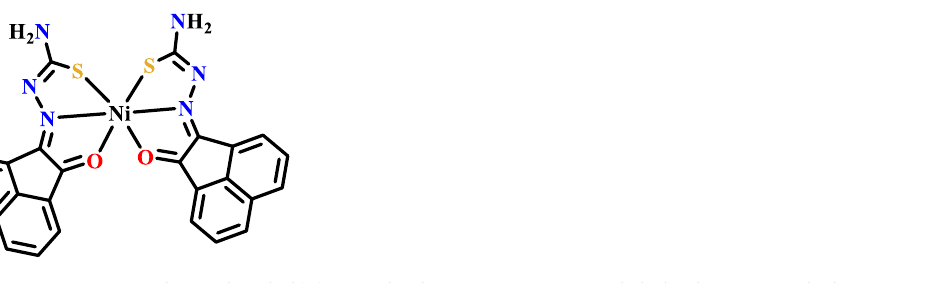
Figure 55. A six-coordinated nickel(II) complex by two same acenaphthehydrazone with thiourea as a side chain.